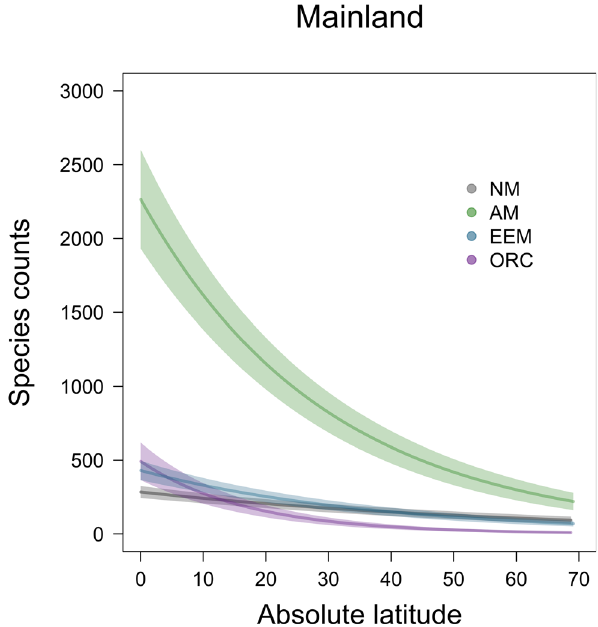
Fig. 5 Latitudinal patterns across mycorrhizal types in native mainland plant species. The latitudinal plant species gradient is strongly in fl uenced by arbuscular (AM) and orchid (ORC) mycorrhizal plant species. In mainland regions, the proportion of mycorrhizal plant species decreases with absolute latitude (degree from equator) more strongly for arbuscular mycorrhizal (green line: absolute latitude estimate = − 0.042±0.080, p = 0.60, n = 515; squared latitude estimate − 0.414±0.080, p <0.001, n = 515; GLM), than for ectomycorrhizal and ericoid (EEM) plant species (blue line: absolute latitude estimate = 0.051±0.082, p = 0.54, n = 515; squared latitude estimate = − 0.400±0.082, p <0.001, n = 515; GLM) and orchid mycorrhizal plant species (purple line: absolute latitude estimate = − 1.216±0.144, p <0.001, n = 486; squared latitude estimate = 0.283±0.144, p = 0.05, n = 486). Non-mycorrhizal species counts plotted for reference (gray line: absolute latitude estimate = 0.132±0.132, p = 0.1, n = 486; squared latitude estimate = − 0.330±0.080, p <0.001, n = 486; GLM). Con fi dence intervals represent 95% con fi dence